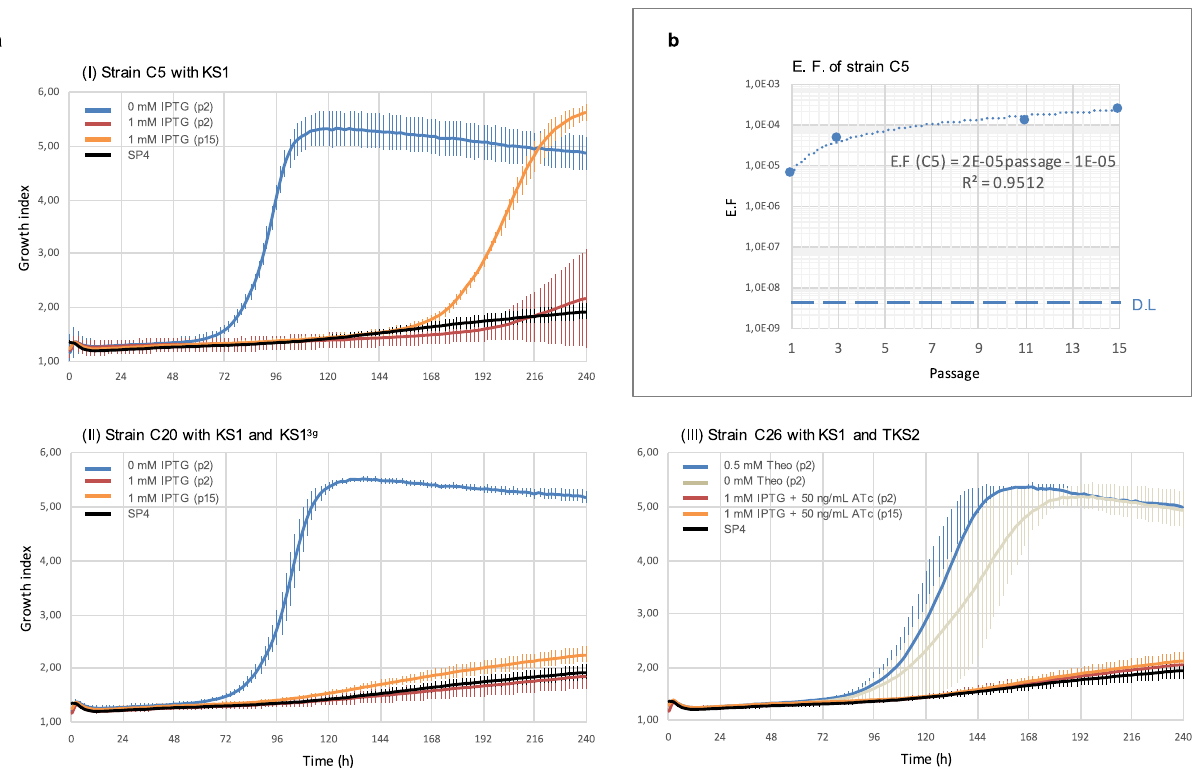
Fig. 4 Study of the long-term performance of the three biosafety systems in clonal M. pneumoniae strains. a Growth kinetics (growth index corresponding to the ratio Abs430 nm/Abs560 nm) of the clonal strains C5 (I), C20 (II) and C26 (III) analysed at an early (p2) and late passage (p15) at different induction conditions. We compare the growth of strains C5 and C20 (with one and two copies of the kill-switch KS1, respectively) when uninduced at the early passage p2 (0 mM IPTG, blue lines) or IPTG-induced that triggers the kill-switch at the passage 2 (1 mM IPTG; p2, red lines) or passage 15 (1 mM IPTG; p15, orange line). We analysed the growth of strain C26 (with KS1 and TKS2) in theophylline-medium (0.5 mM Theophylline, permissive growth conditions with both circuits inactive, blue line), or theophylline-free medium (0 mM Theophylline, slow activation of TKS2, light brown line) in the early passage p2. The growth is also analysed when both circuits are activated simultaneously in ATc and IPTG medium at passage 2 (1 mM IPTG and 50 ng/mL ATc; p2, red line) or passage 15 (1 mM IPTG and 50 ng/mL ATc; p15, orange line). The black line is a negative control of the growth index reads from an empty medium and shows the baseline of these long experiments, as the Abs560 reads have a drift (SP4, black line). Mean values from three bio-replicates. Error bars indicate standard deviation. b Escape frequency (EF) for strain C5 at several strain passages, determined as the ratio between IPTG-resistant CFUs and the total CFUs. The dashed line shows the detection limit calculated in the analysis, considering the total CFUs plated. Source data are provided as a Source Data fi